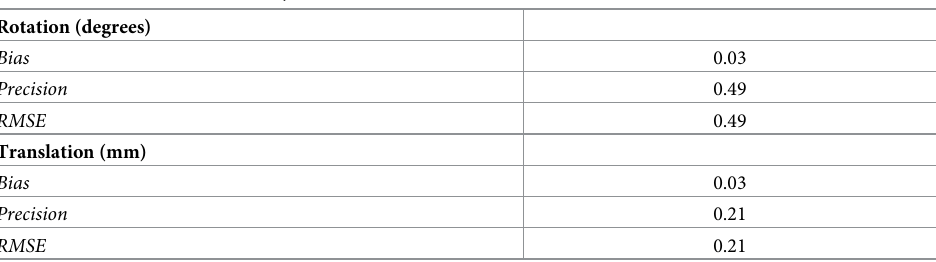
Table 3. Validation block summary of means.